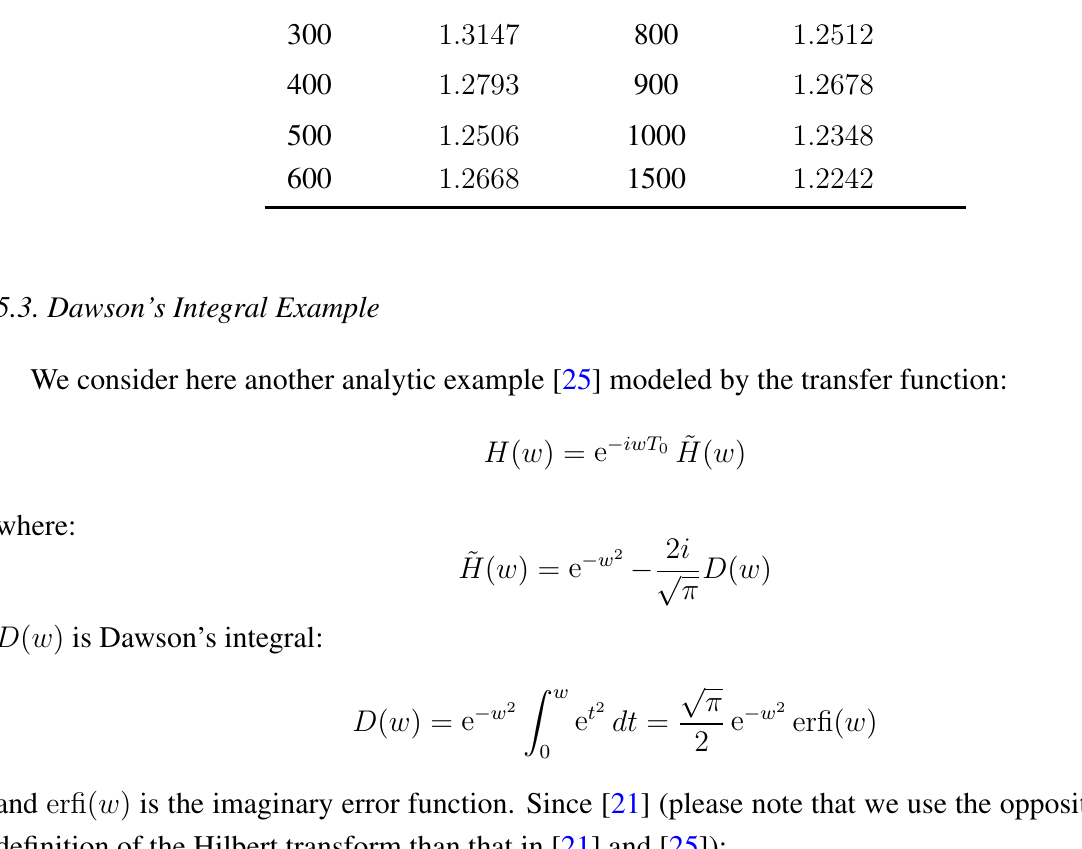
Table 5. Approximations of T for various M . The exact value T